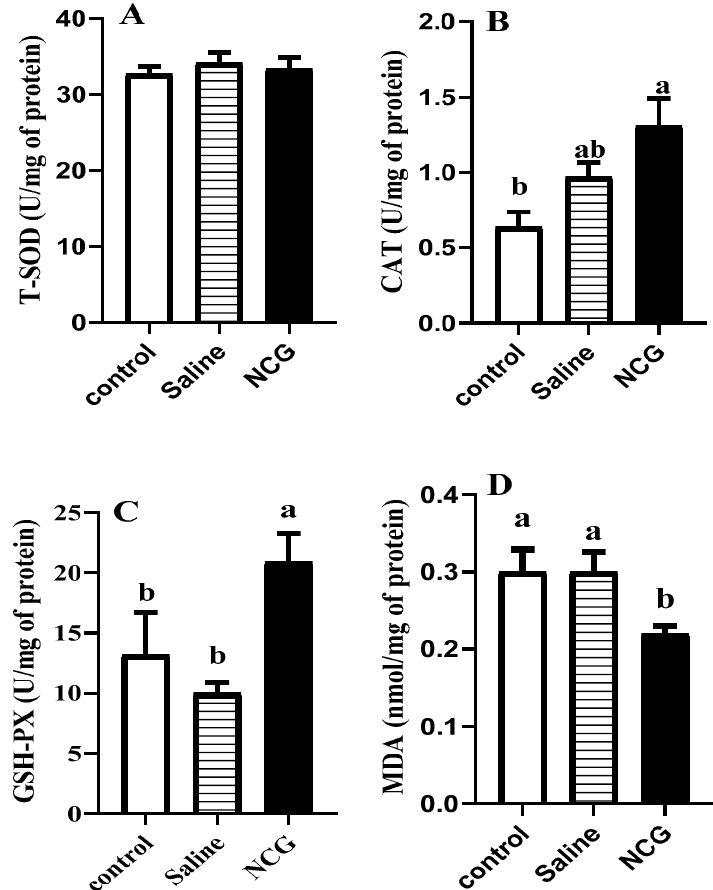
Figure 1. ( A – D ). Antioxidant activity of pectoral muscle in broilers. Values represent the mean + SEM (n = 6). Different superscript (a-b) indicate a significant difference ( p < 0.05). Control = non-injected control group; Saline = saline-injected control group (8.5 g NaCl dissolved in 1 L distilled water); NCG = 2 mg NCG solution-injected group (20 g NCG dissolved in 1 L saline).